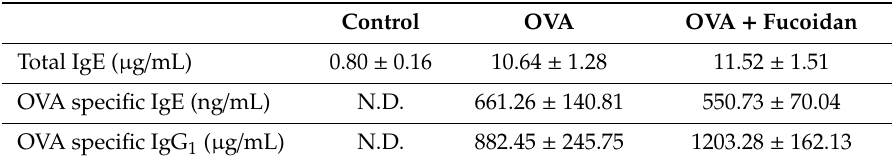
Table 1. E ff ect of F-fucoidan on total IgE, OVA-specific IgE and OVA-specific IgG 1 contents in OVA sensitized